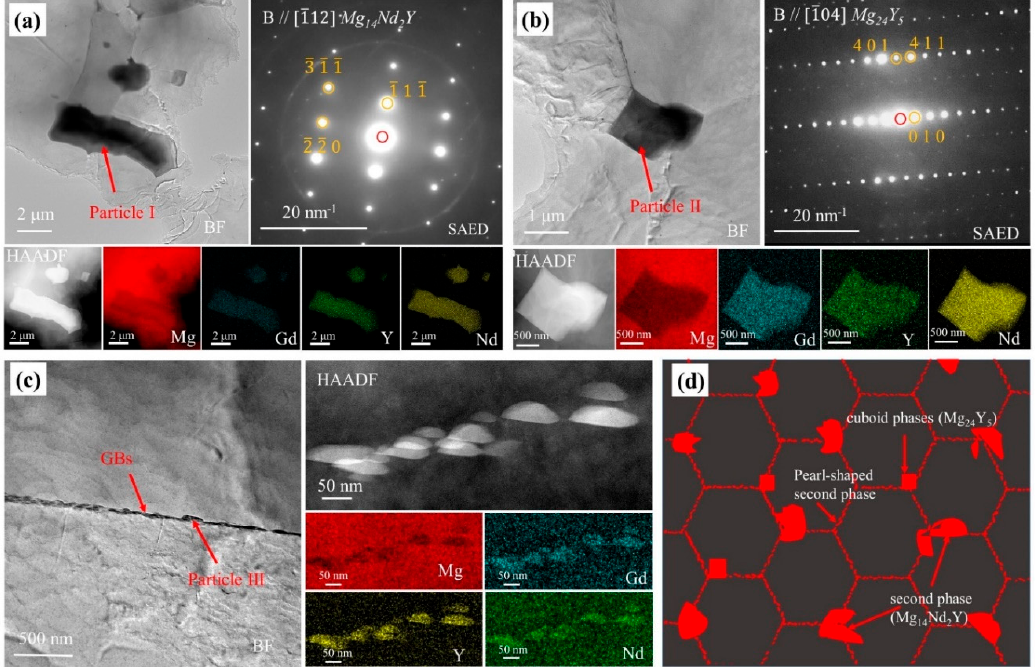
Figure 3. TEM bright–field images and corresponding SAED patterns, HAADF–STEM image and corresponding EDS elemental mappings, and schematic diagram of extruded WE43 alloy: ( a ) Particle I in extruded WE43 alloy; ( b ) Particle II in extruded WE43 alloy; ( c ) Particle III in extruded WE43 alloy; ( d ) schematic diagram of extruded WE43 alloy.